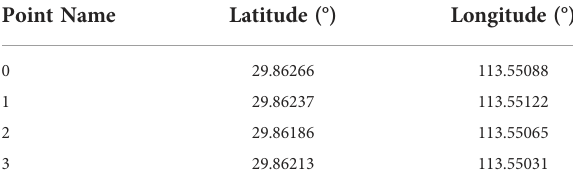
TABLE 4 Simulation test regular fi eld plot contour point information.